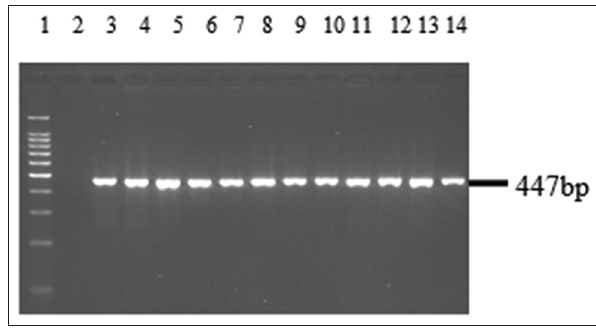
Figure-1: Modified species-specific polymerase chain reaction for Helicobacter pullorum. Lane: 1 - marker 100 bp ladder lane, 2 - Campylobacter jejuni ATCC 24928 lane, 3 - H. pullorum ATCC 51863 lane, 4-14 - H. pullorum isolates.